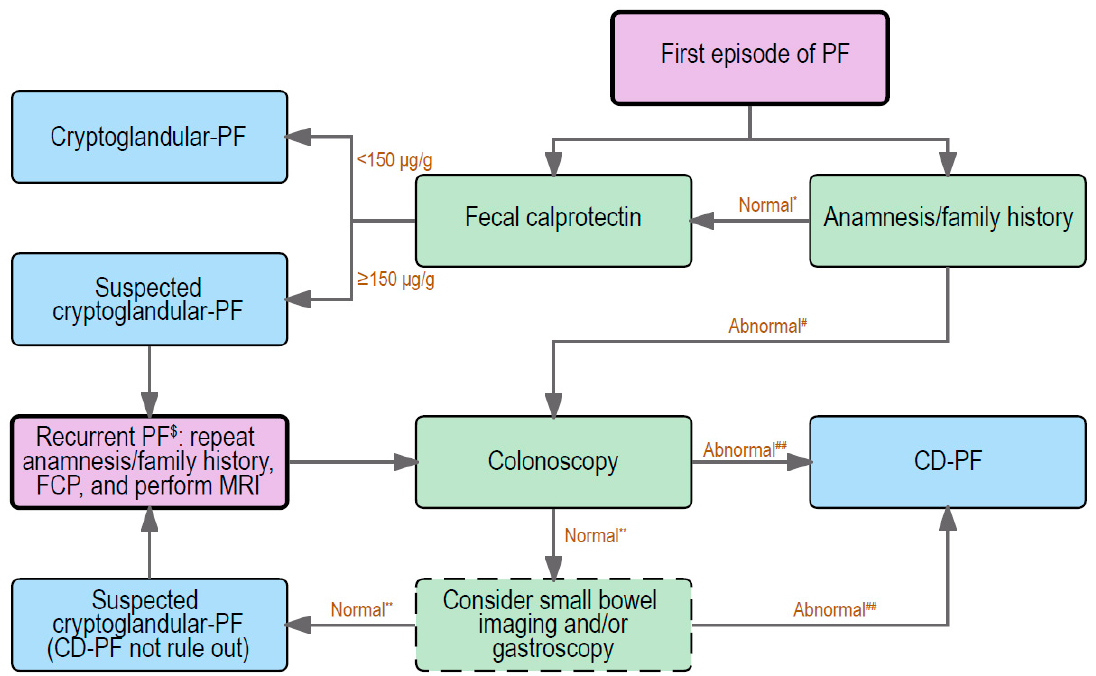
Figure 3. Flow chart to deal with a patient displaying his/her first episode of perianal fistulas. PF: perianal fistula; CD-PF: CD-associated perianal fistula. *: No CD-associated symptoms, no IMDs, and no IBD relatives. # : CD-associated symptoms, or/and IMDs, or/and IBD relatives. **: no intestinal inflammation. ## : intestinal inflammation. $ : within one year. FCP: fecal calprotectin; MRI: magnetic resonance imaging.